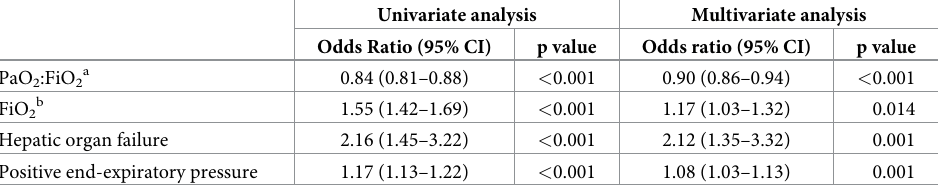
Table 3. Logistic regression model for predicting persistent severe ARDS using variables available at trial